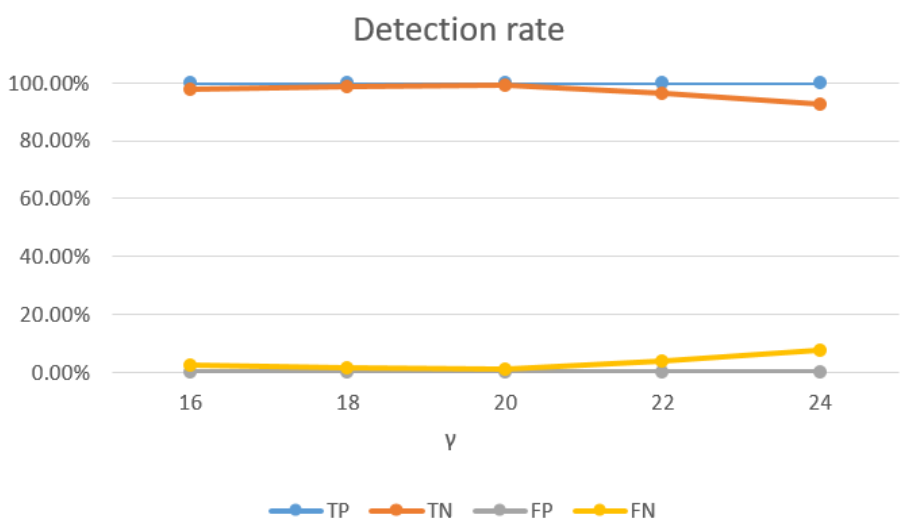
Figure 16. Relationship between detection rate and γ ( C =